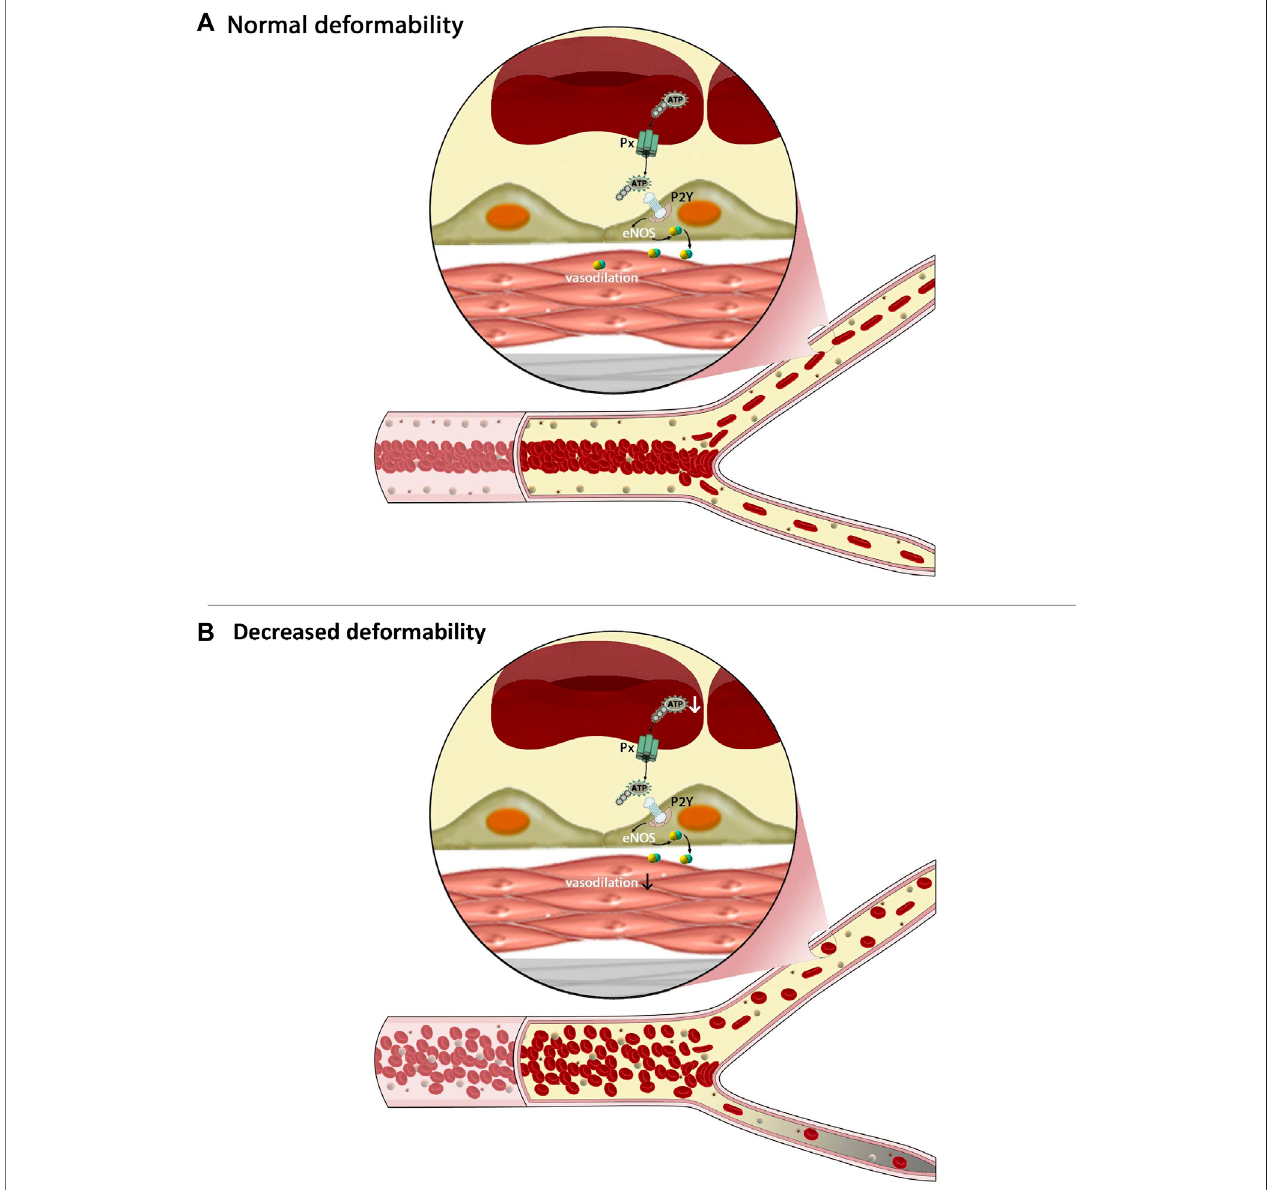
FIGURE 2 | The fi gure demonstrates some of the complex interactions between cellular mechanics of red blood cells (RBC), the fl ux of the microcirculation, and intracellularsignalingwithinthesecells.Underhealthyconditions,RBCarehighlydeformable,whichenablesthemtomigratetothecenterof fl owtherebycreatingacell- poor layer (A) and to pass easily throughout daughter branches of the microcirculation. Less deformable RBC (B) , however, tend to have greater heterogeneity of distribution within larger vessels, resulting in a much narrower cell-poor layer and thus greater wall shear stress. Upon reaching bifurcations, these rigid RBC are unable to enter smaller capillaries, prompting a maldistribution of RBC and impaired fl ux of these pathways. Other mechanisms are also of critical importance, such as hypoxic vasodilation, yet not shown on this fi gure.